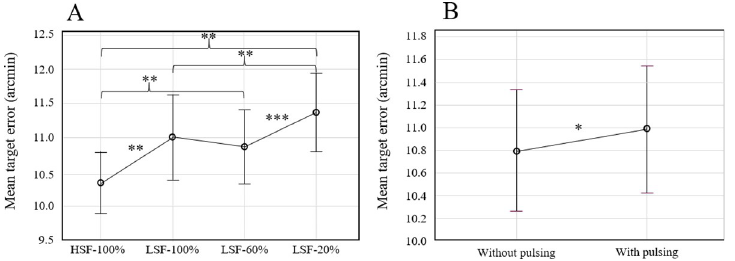
Fig 10. From left to right, respectively mean target error considering binocular background characteristics (A) and with or without pulsing (B). Error bars represent standard error, and main effects are indicated as follows: � p < 0.05, �� p < 0.01, ��� p <